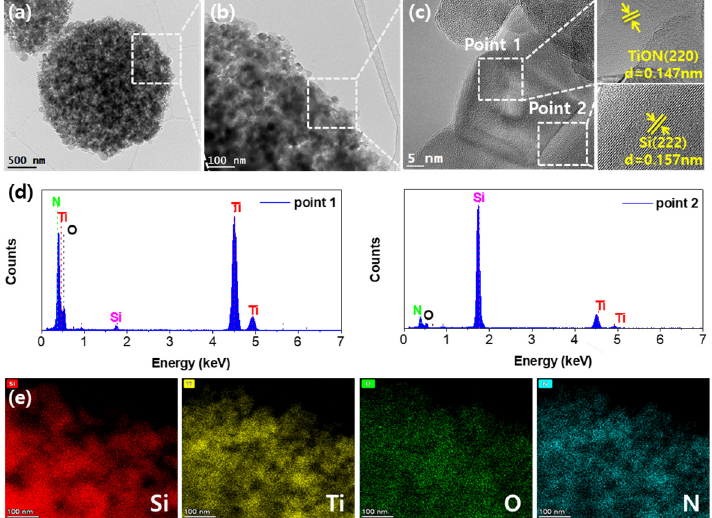
Figure 3. HRTEM images of Si-TiON (1:1) composite at ( a ) low and ( b , c ) high magnifications. Right inset shows lattice fringes within the TiON coating layer and Si core particle along directions (004) and (222), respectively. ( d ) Energy-dispersive X-ray spectra from points 1 and 2 in ( c ). ( e ) Si, Ti, O, and N elemental mapping indicating that TiON was well-distributed in the shell region.